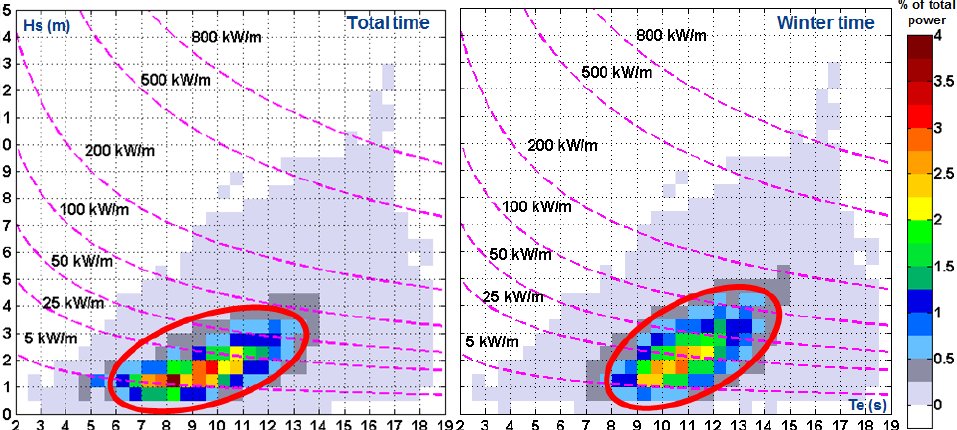
Figure 1. The specific pattern for the west Iberian nearshore, scatter diagrams H resulted from 41 years (1960–2000) of WAM (acronym for Wave Modeling ) simulations (structured in total and winter time, respectively). The color scale is used to represent the contribution of the sea state to the total incident energy, as a percentage. The wave power isolines are also